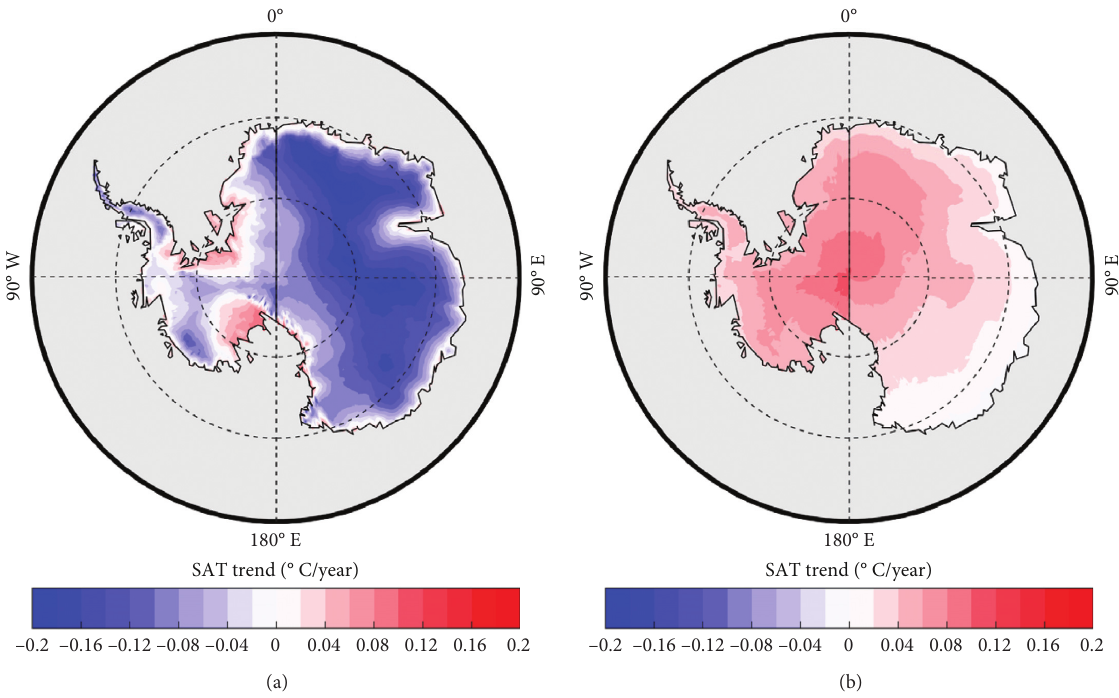
Figure 8: Spatial patterns of the SATtrends derived from the estimated SATdatasets during (a) 1960–1989 and (b) 1990–2019, respectively. The trend on each grid is calculated using the Mann–Kendall trend test method